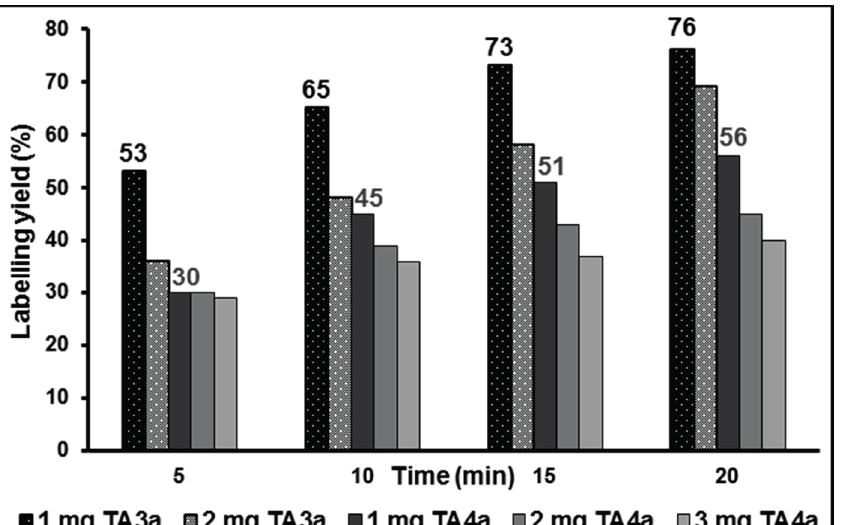
Figure 4. Optimization of the labelling yields for aliphatic 18 F-radiolabelling of the tosylate precursors TA3a and TA4a by varying the amount of precursor and the reaction time (in MeCN at 80 °C, conventional